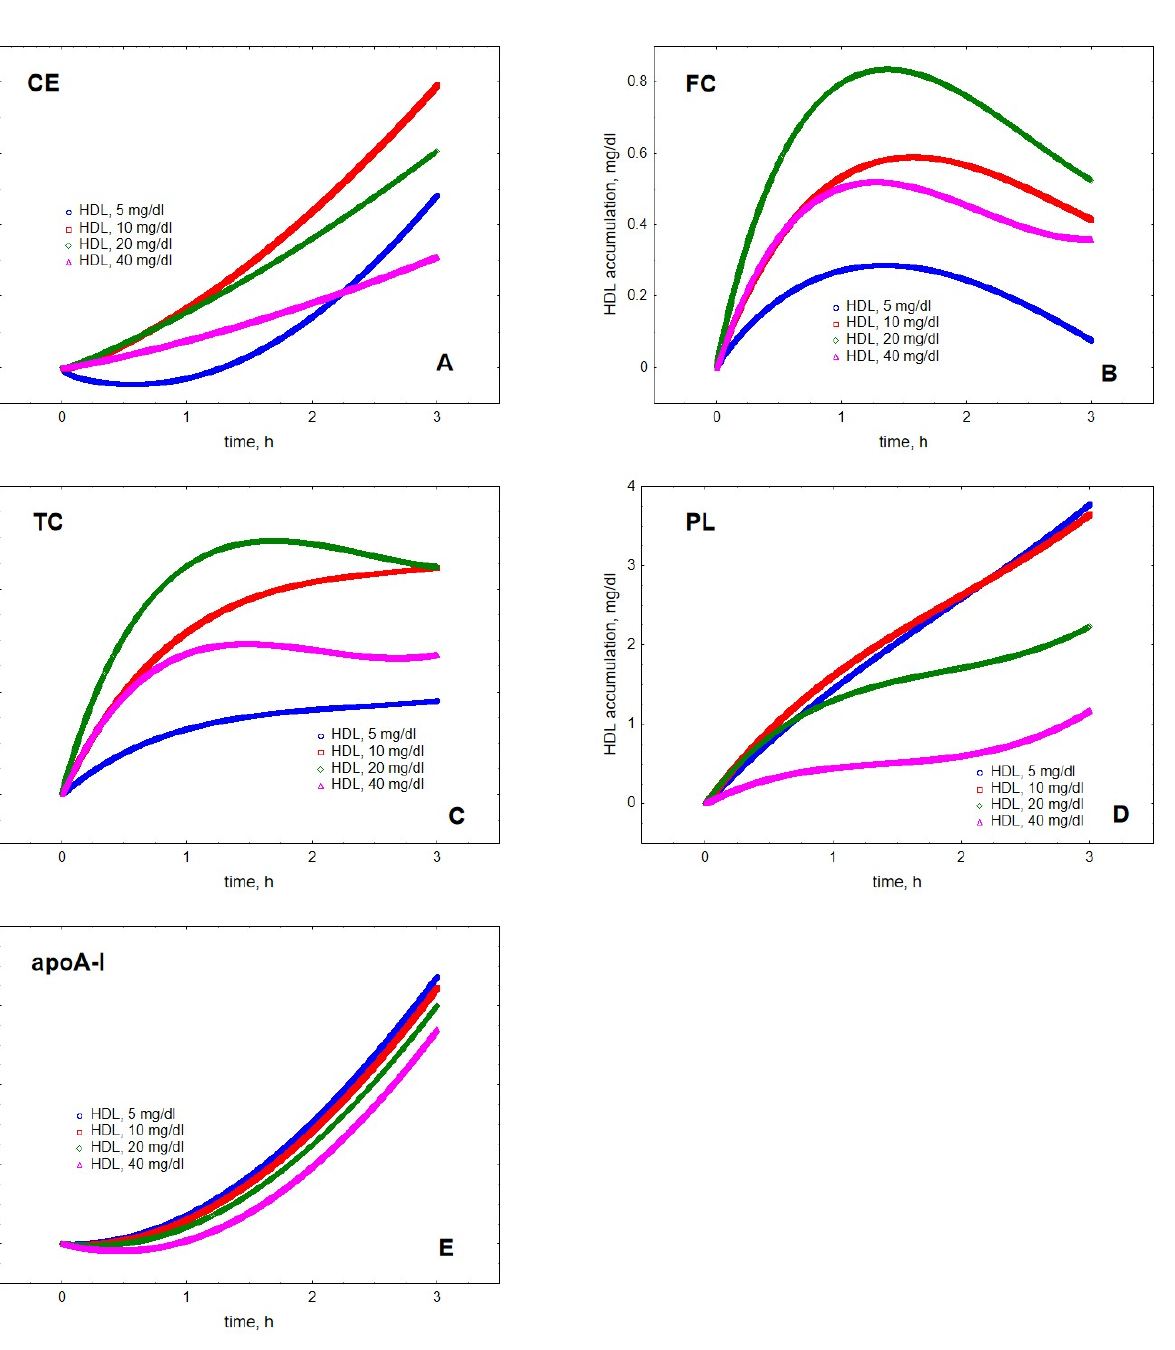
Figure 2. Kinetics of the accumulation in HDL of CE ( A ), FC ( B ), TC ( C ), PL ( D ) and apoA-I ( E ) during VLDL lipolysis by LPL in the presence of HDL. Mathematical modelling was performed under conditions of in vitro TGRL lipolysis described elsewhere [25]. In order to calculate accumulation in HDL of a given component, its content at baseline (t = 0) was subtracted from the results of the modelling. Initial concentrations: HDL, 5 (blue circles), 10 (red squares), 20 (green diamonds) and 40 (purple triangles) total mass/dL; VLDL-TG, 30 mg/dL; LPL, 190 U/mL. The modelling showed that the accumulation of lipids and protein in HDL depended on the concentration of acceptor HDL particles. Interestingly, HDL content of CE, FC and TC peaked at intermediate HDL concentrations of 10 to 20 mg/dL (Figure 3). Indeed, maximal CE accumulation in HDL of +0.8 mg/dL (+49%) relative to baseline was found at the intermediate HDL concentration of 10 mg/dL, whereas maximal FC and TC